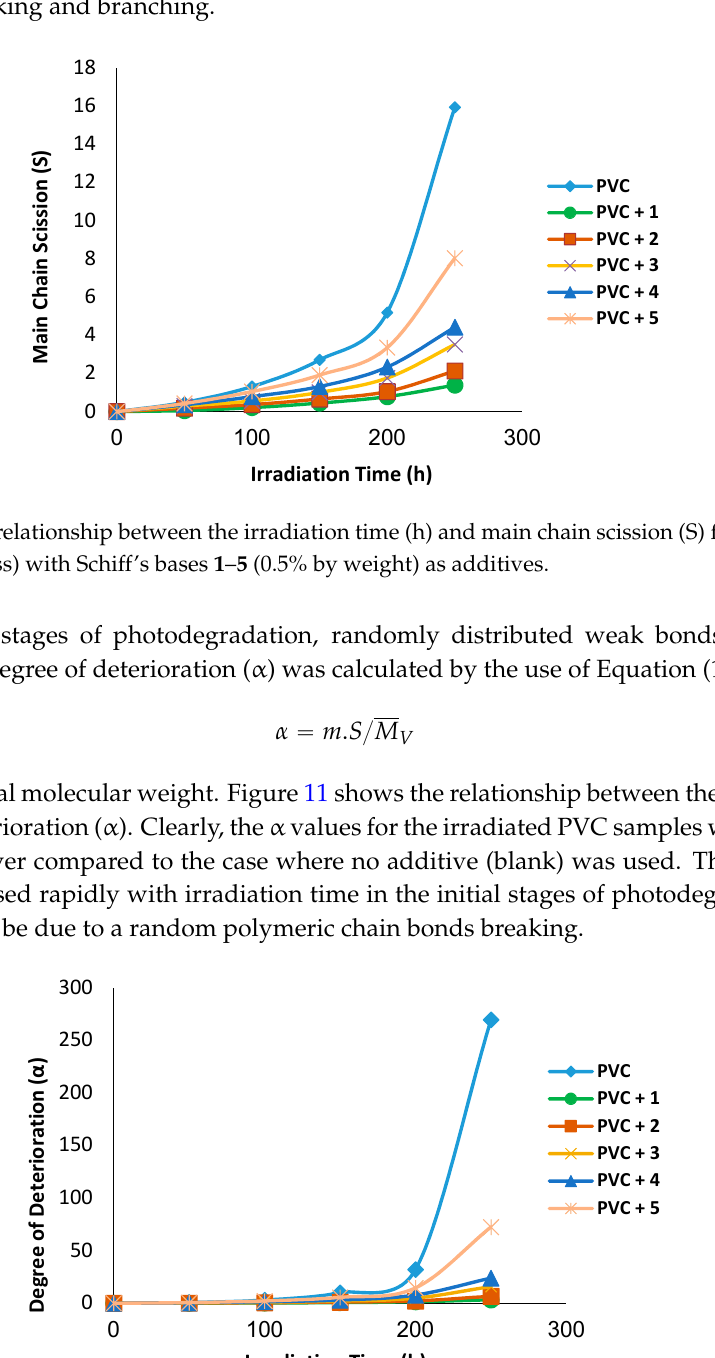
Figure 11. The relationship between the irradiation time (h) and degree of deterioration ( α ) for PVC films (30 μ m thickness) with Schiff’s bases 1 – 5 (0.5% by weight) as additives.